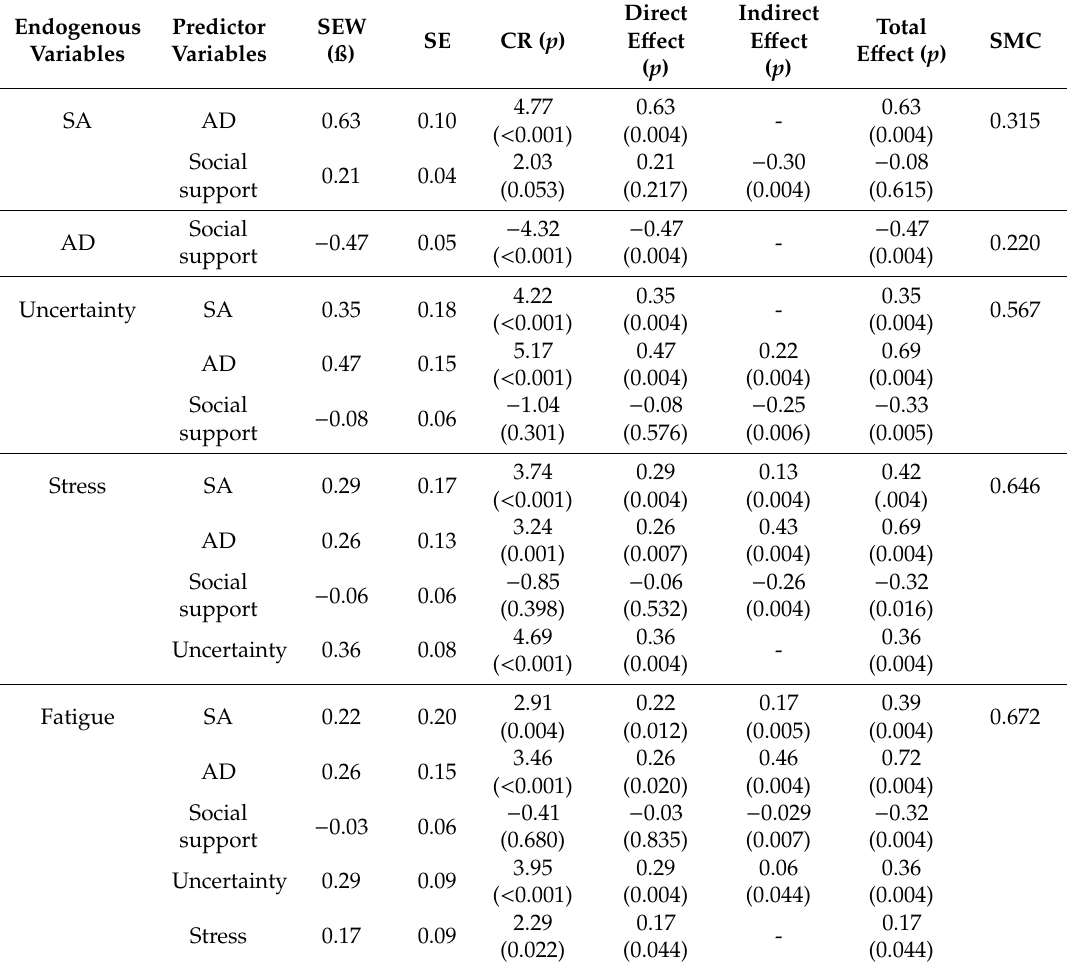
Table 3. The suitability and direct, indirect, and total e ff ects of the structural